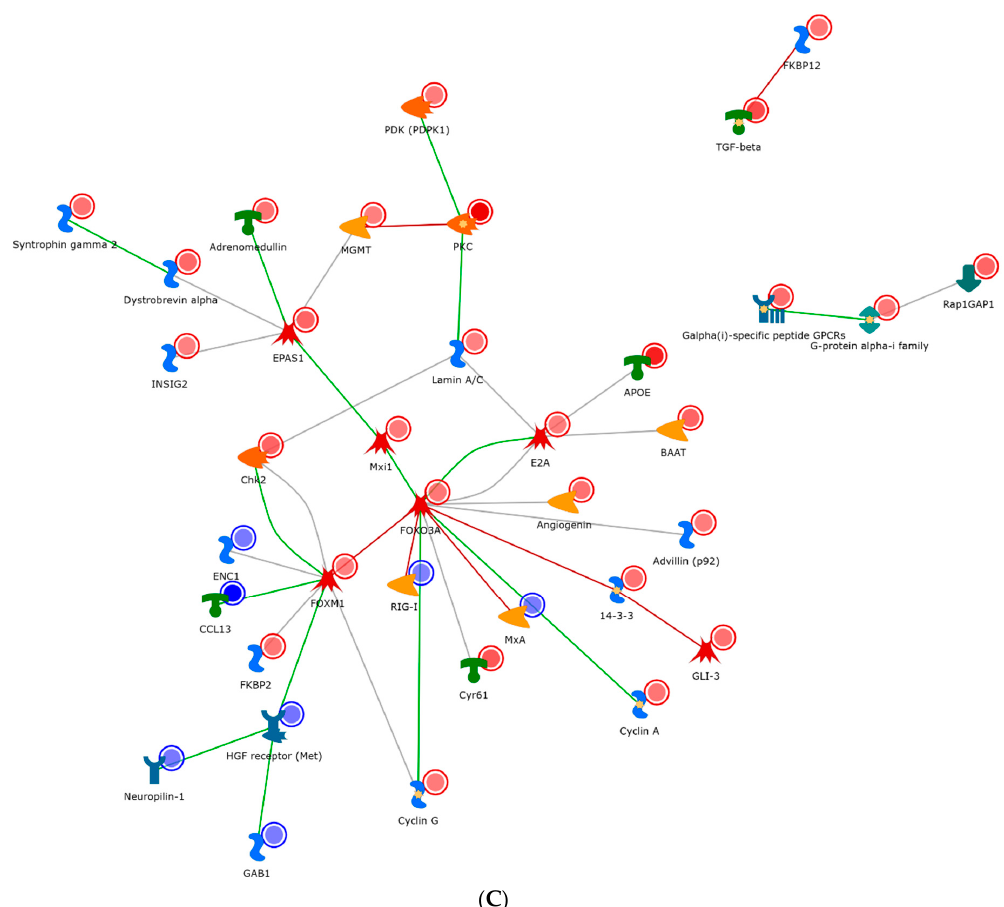
Figure 5. Gene regulatory networks stimulated by IL-2 ( A ), IL-7 ( B ), and IL-15 ( C ) in activated CD4 + T cells. The meaning of the icons/modules shown in this figure can be found in the software MetaCore . The IL-2 network was clustered through the oncogene Src, general GPCR signaling, and the transcription factor AP-1. The IL-7 network shared many similar factors as the IL2 one, but it included and expanded repertoire of nodes, specifically around the transcriptional regulators (EGR1, P73, and E2A). The IL-15 network appeared the most dissimilar to IL-2 / 7 and radiated through a hub of the transcription factors FOXM1 and EPAS1 and cellular morphogenesis.